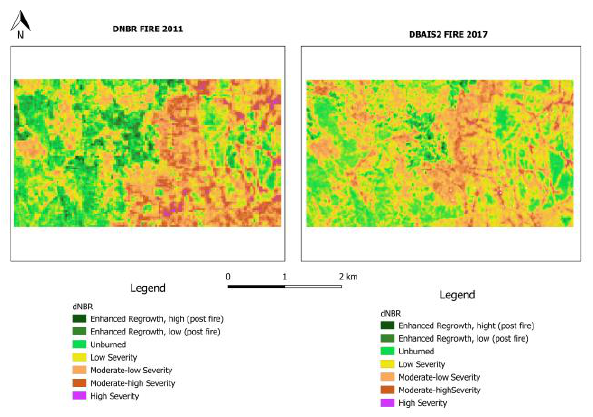
Figure 9. Burn severity levels by dNBR and dBAIS2